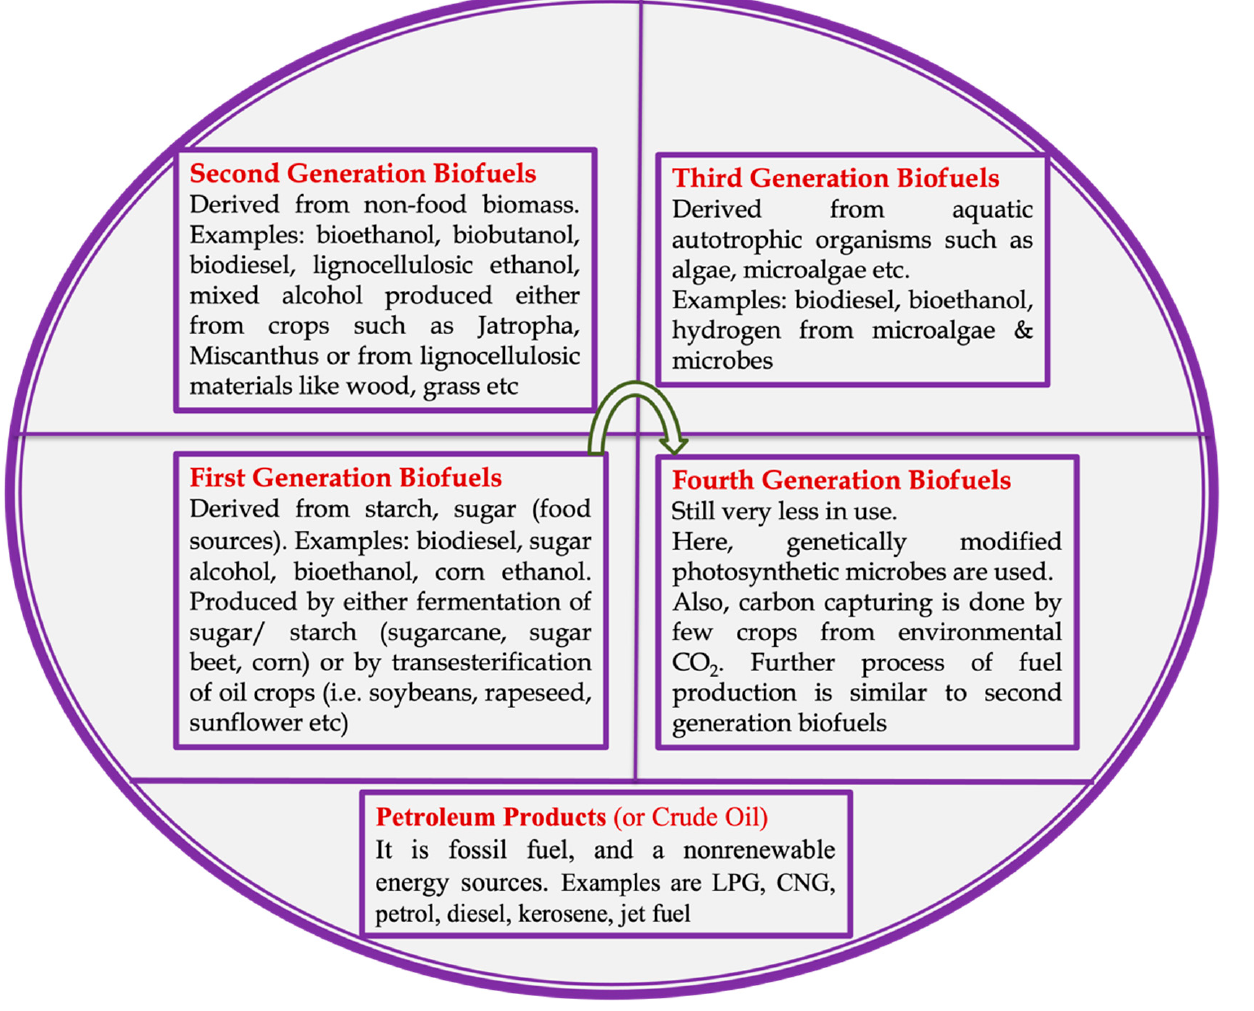
Figure 1. Comparison of first-, second-, third-, and fourth-generation biofuels, and petroleum fuels (adopted and modified from Naik et al. [13] and Dragone et al. [25]).